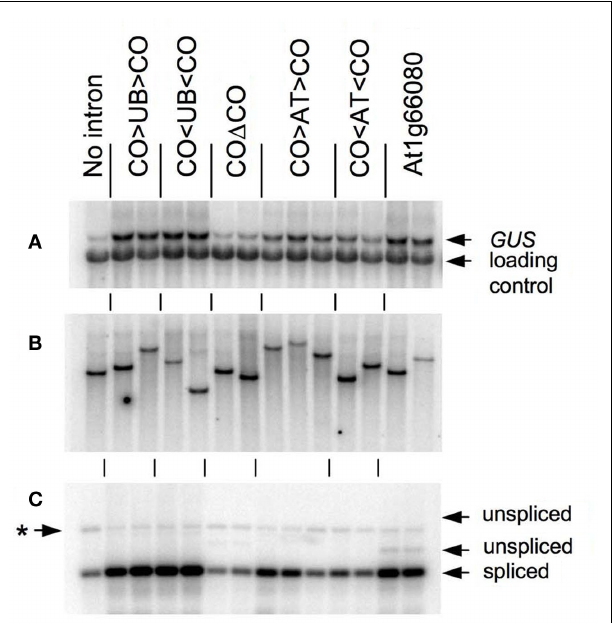
FIGURE 2 |Analysis of TRP1:GUS transgenic lines. (A) RNA gel blot of total RNA from lines transgenic for TRP1:GUS fusions containing the indicated intron, probed with GUS and a loading control. (B) Genomic DNA blot digested with Pst I and probed with GUS . (C) RT-PCR analysis of intron splicing with arrows indicating the predicted positions of products derived from spliced and unspliced mRNA as determined by amplification of genomic DNA with the same primers.The asterisk marks a non-specific amplification product.The blots in (A–C) are vertically aligned so that lanes in the same position in each of the three panels are from the same independent transgenic line.